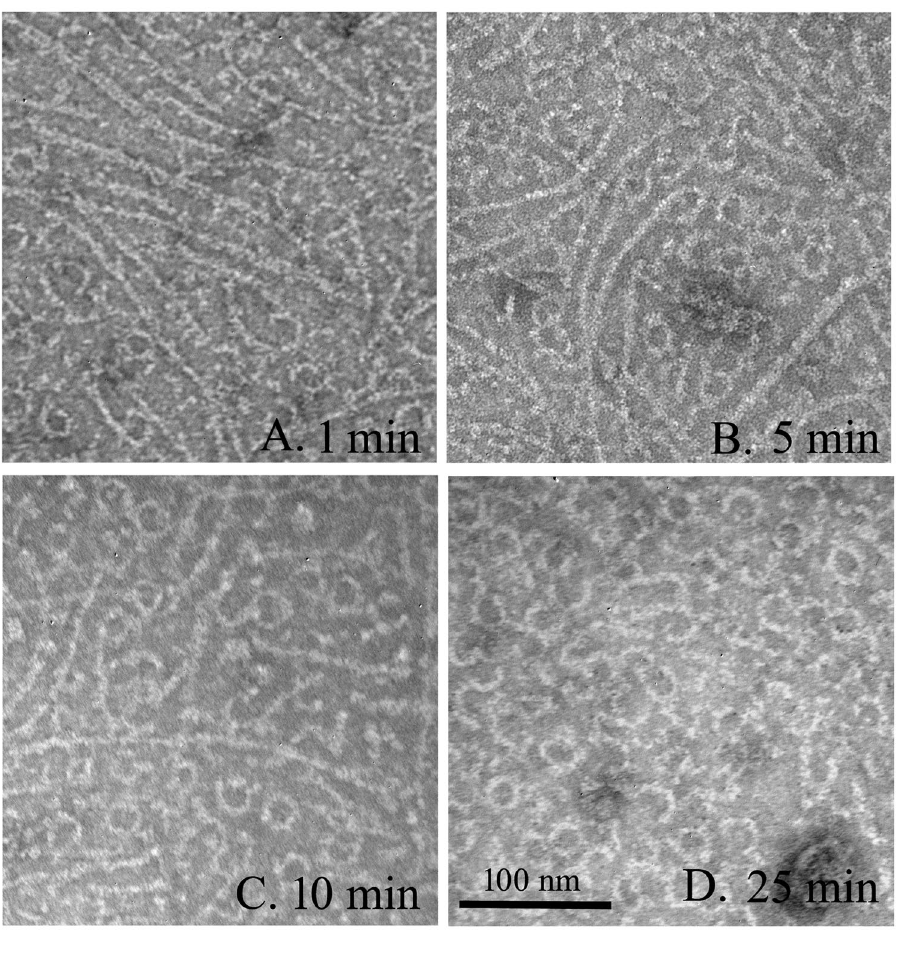
Figure 2. EM images of 5 µ M FtsZ plus 5 µ M ZipA, pH 7.5, at different times after adding 0.5 mM GTP. After 25 minutes, most filaments are miniring structures. Bar is 100 nm.